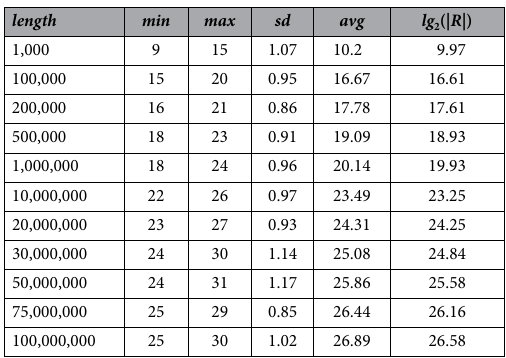
Table 2. For each genome length, 100 trials were performed. The minimum, the maximum and the average, together with the standard deviation, of mrl + 1 was computed for each trial set. With a good approximation lg 2 (| R |) ≈ avg ( mrl ( R ) +